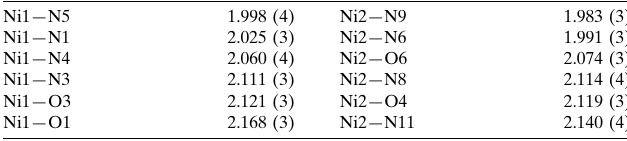
Selected bond lengths (A˚ ).